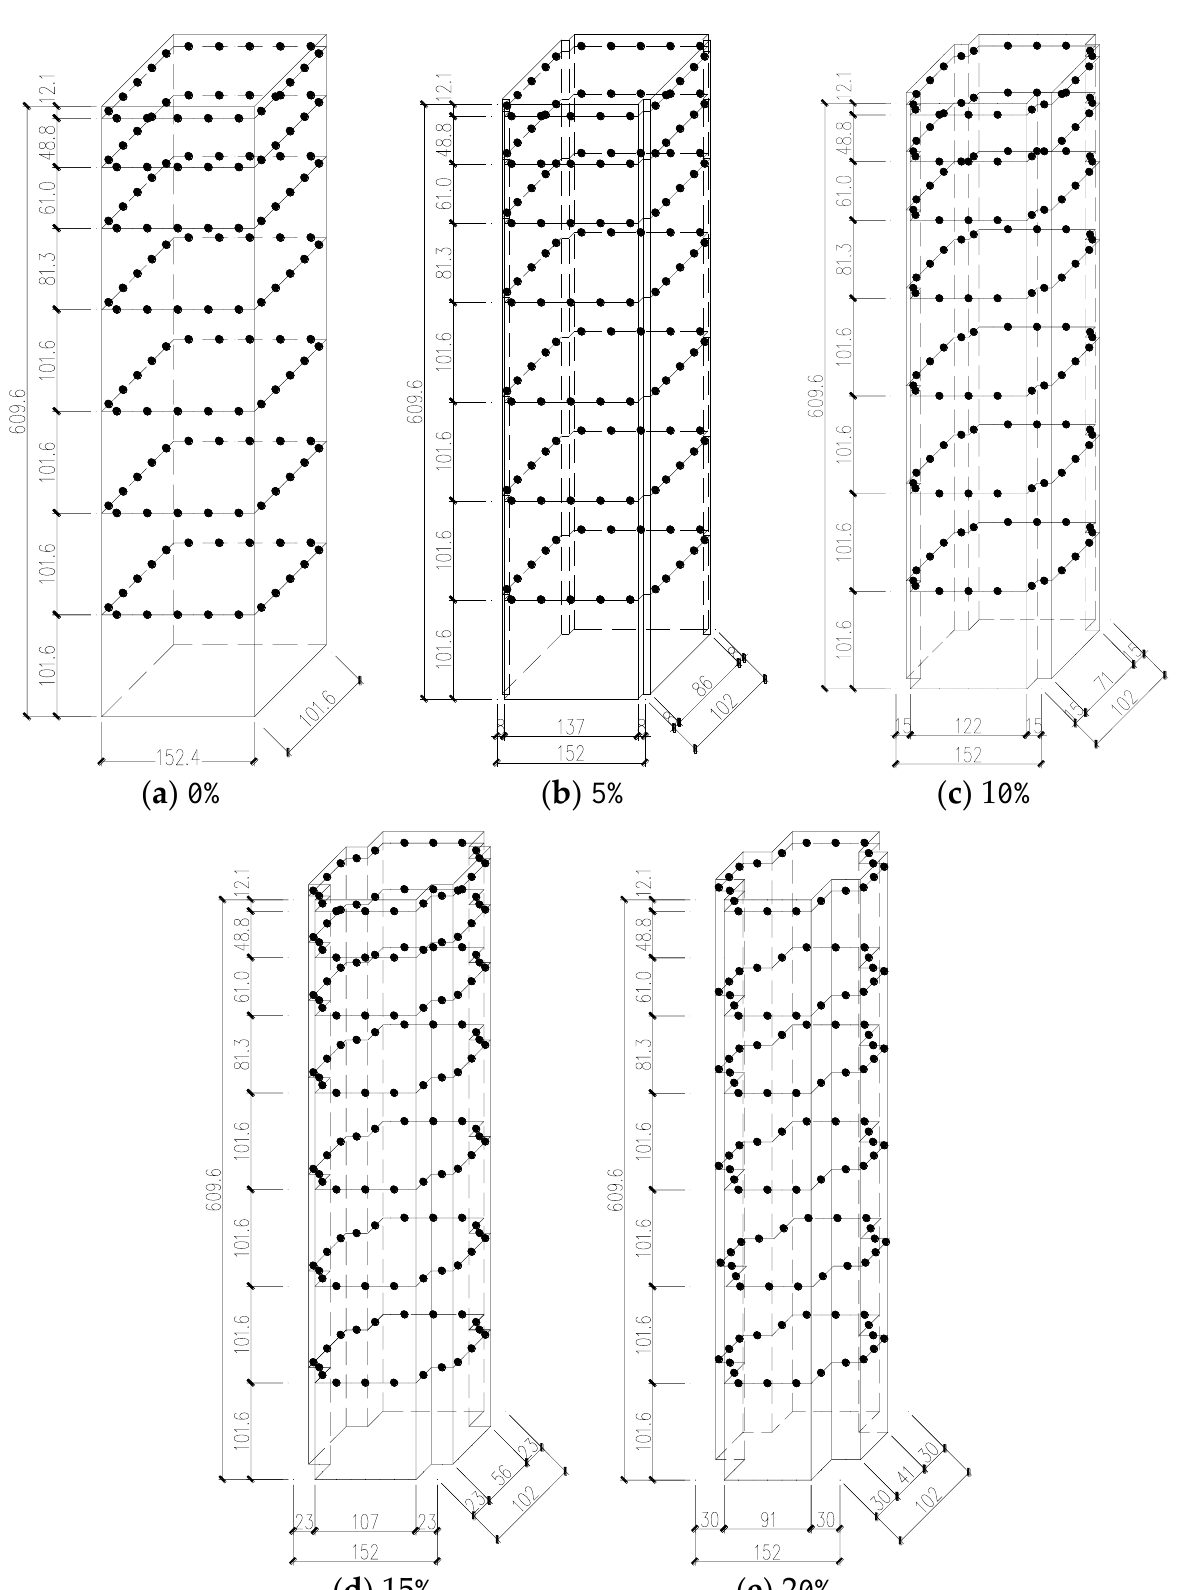
Figure 3. The test model.